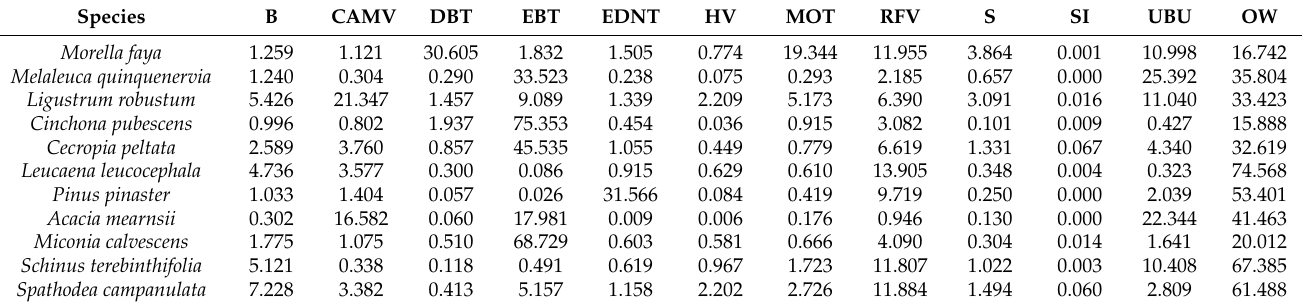
Table 2. Contribution of consensus land-cover classes to the distributions of 11 invasive tree species. B, Barren; CAMV, Cultivated and Managed Vegetation; DBT, Deciduous Broadleaf Trees; EBT, Evergreen Broadleaf Trees; EDNT, Evergreen/Deciduous Needleleaf Trees; HV, Herbaceous Vegetation; MOT, Mixed/Other Trees; RFV, Regularly Flooded Vegetation; S, Shrubs; SI, Snow/Ice; UBU, Urban/Built-up; and OW, Open